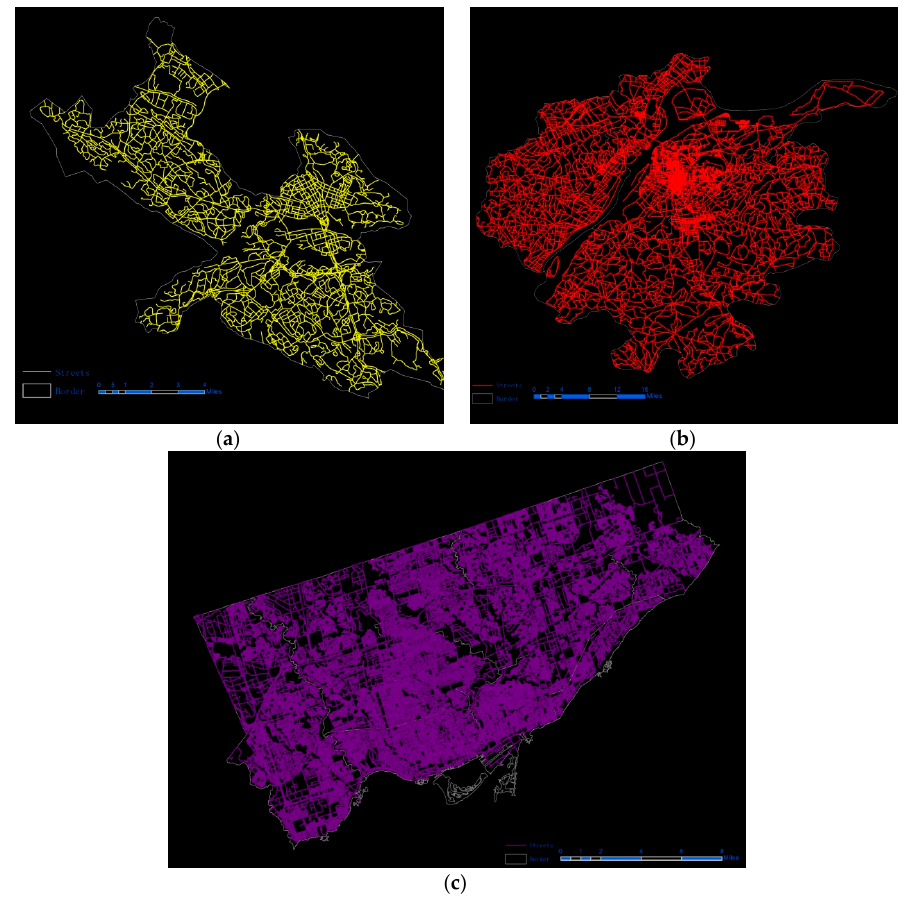
Figure 1. Study areas of city of ( a ) Stockholm; ( b ) Nanjing; and ( c ) Toronto. Table 1. Basic statistics of three cities in 2012.